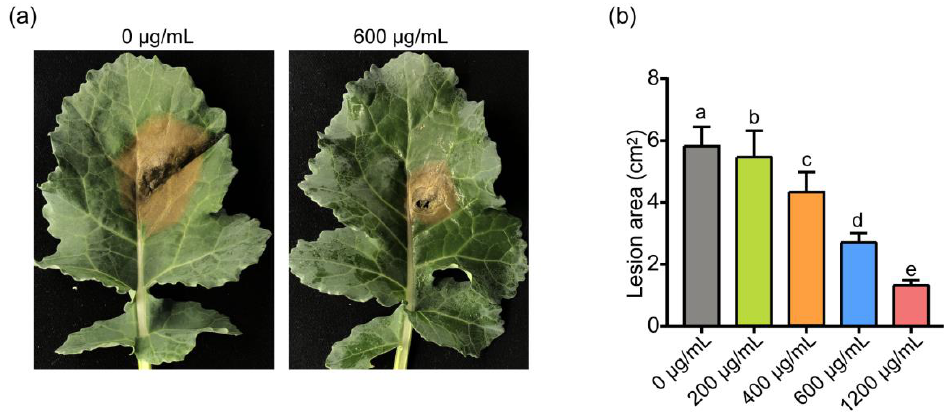
Figure 3. Effects of 0, 200, 400, 600 and 1200 μg /mL of ε -PL on the infection of Sclerotinia scleroti- orum on rapeseed leaves. ( a ) ε - PL at 600 μg /mL significantly reduced necrotic lesion area caused by infection of S. sclerotiorum. ( b ) Effect of different concentrations of ε -PL on the necrotic lesion induced by S. sclerotiorum. Different letters indicate significant differences ( p < 0.05).